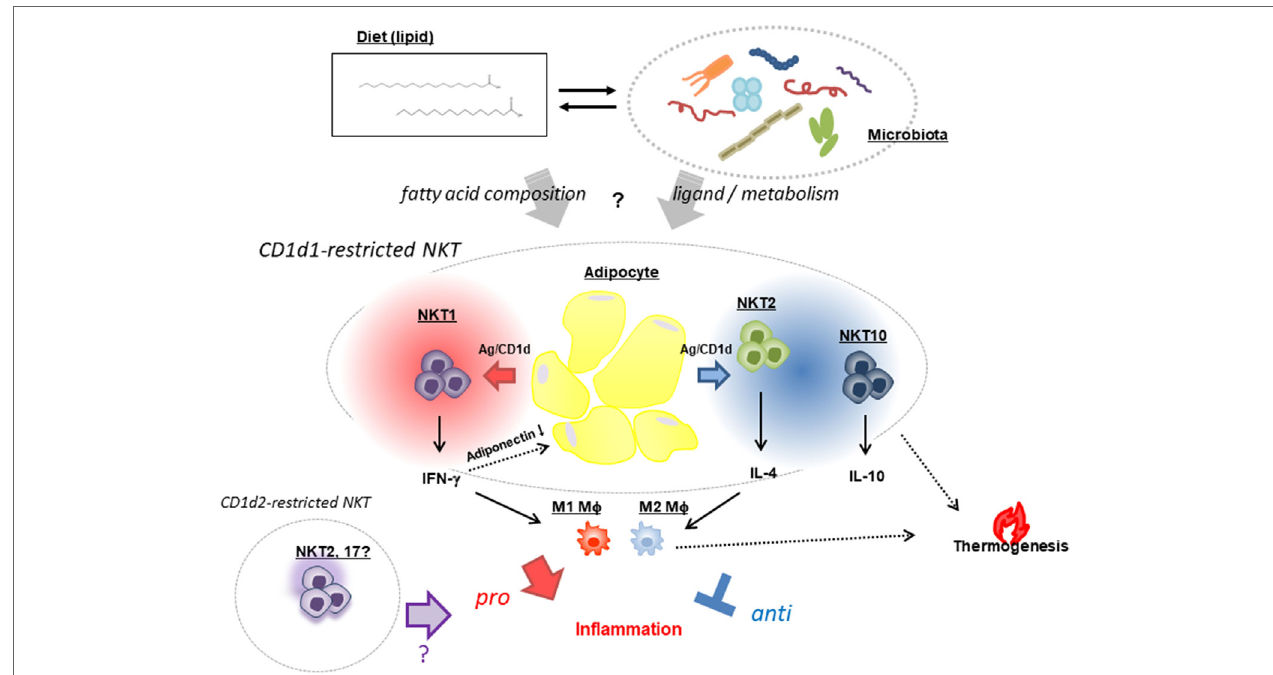
FiGURe 1 | Natural killer T (NKT) cell-based modulation of AT inflammation. NKT cells exhibit opposing functions: a pro-inflammatory response that promotes AT inflammation and insulin resistance through release of IFN- γ (NKT1) that reduces the pro-ameliorating adipokine adiponectin, and a regulatory response that suppresses inflammation via production of IL-4 (NKT2) and -10 (NKT10) and increased thermogenesis leading to energy expenditure. These NKT [mostly cluster of differentiation (CD)1d1-restricted and very few, if any, CD1d2-restricted] cell functions are presumed to be affected by two mutually interacting factors—namely, dietary fat composition and a microbiome in which the Bacteroidetes and Firmicutes phyla